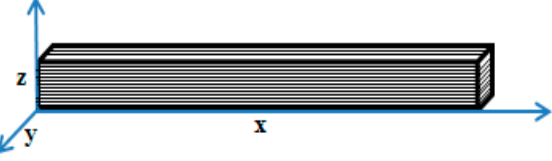
Figure 1. Orthogonal coordinate system of laminate.